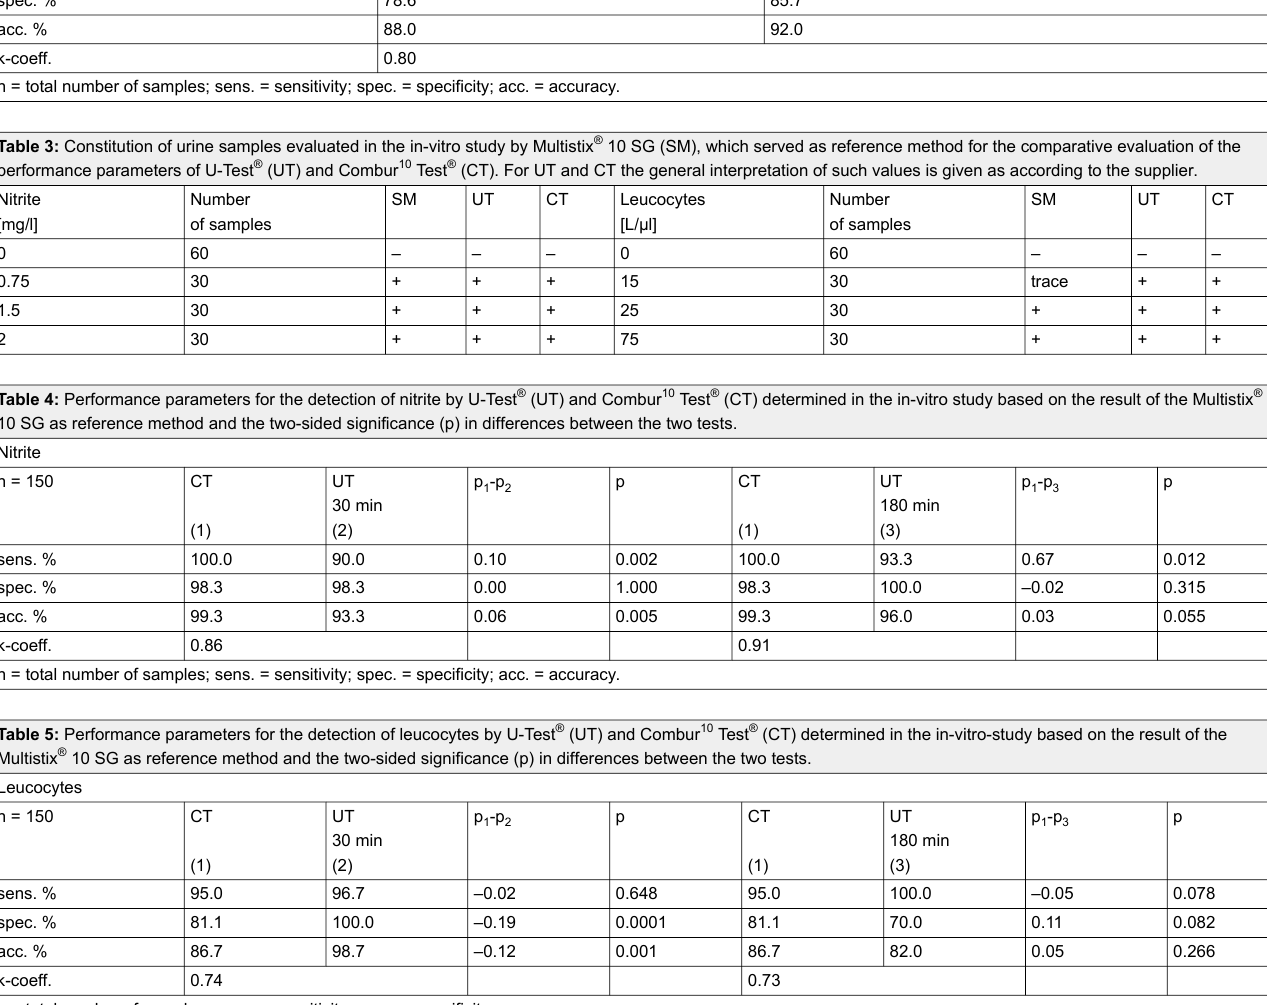
Table 2: Performance parameters of U-Test ® and the dipsticks determined in the clinical study based on the result of the urine culture as reference method. n = 25 U-Test ® Dipstick sens. % spec. % acc. % κ-coeff. 0.80